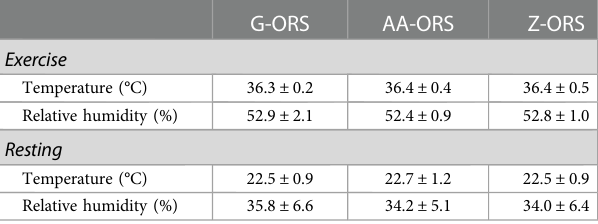
TABLE 1 Laboratory environmental conditions during exercise and resting